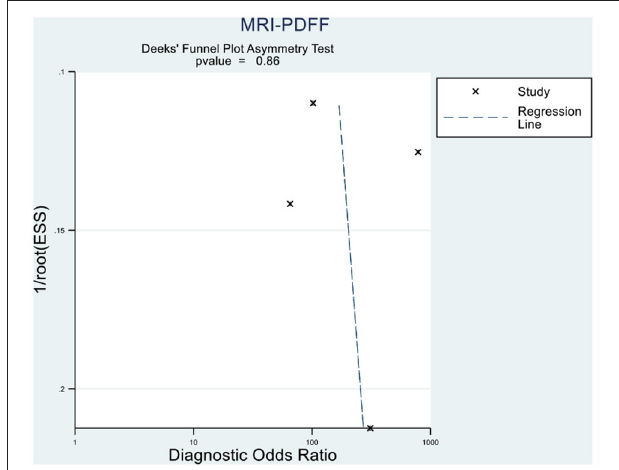
FIGURE 6 | Deeks’ funnel plot asymmetry test to evaluate the publication bias of MRI-PDFF and TE-CAP (S0 vs. S1–S3).